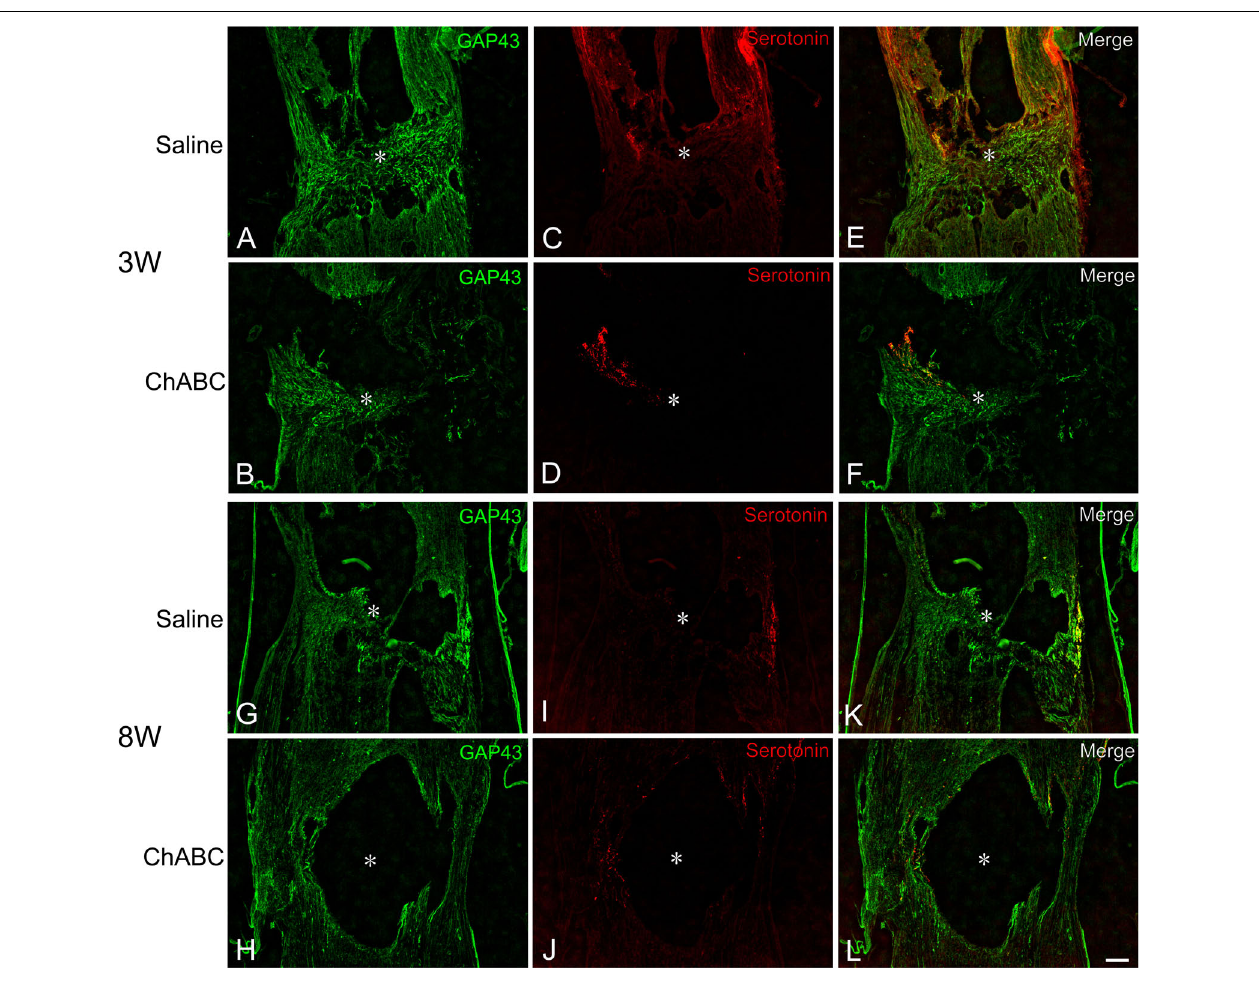
FIGURE 3 | Double-labeled images of immunohistochemistry for 5-hydroxytryptamine (5-HT) (red), and GAP-43 (green) in the lesion site of rats with saline (A,C,E,G,I,K) , and ChABC (B,D,F,H,J,L) administration at 3 (A–F) , and 8 weeks (G–L) after CST. Images of GAP-43 (A,B,G,H) , 5-HT (C,D,I,J) , and merged images (E,F,K,L) are shown. Arrows indicate nerve fibers doubly positive for 5-HT and GAP-43. Asterisks indicate the center of the lesion site. Scale bars = 100 µ m.